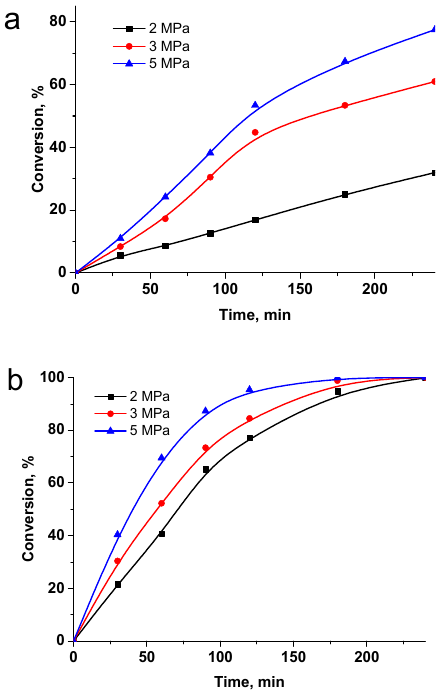
Figure 8. The effect of pressure on the hydrogenation of LA to GVL in the presence of Ru-PPP ( a ) and Ru-PPP-S ( b ) at 100 °C. Reaction conditions: LA 1 g, solvent 50 mL, catalyst loading 0.064 mol.% of Ru for Ru-PPP and 0.016 mol.% for Ru-PPP-S. It should be noted that no intermediate products, such as angelica lactone, have been detected for both catalysts. It may indicate that the reaction proceeds through the for- mation of unstable 4-hydroxypentanoic acid, which undergoes rapid cyclization to GVL and is constituent with the literature data [9,50,51]. The high selectivity and yield of GVL along with the mild reaction conditions are characteristic for this route [4]. The use of Ru- PPP and Ru-PPP-S allows for quantitative yields of GVL within 4 h, but the conversion of LA differs dramatically. The data on catalytic performance of the catalysts are summa- rized in Table 1. Table 1. The results of LA hydrogenation in the presence of the Ru-PPP and Ru-PPP-S catalysts. Catalyst